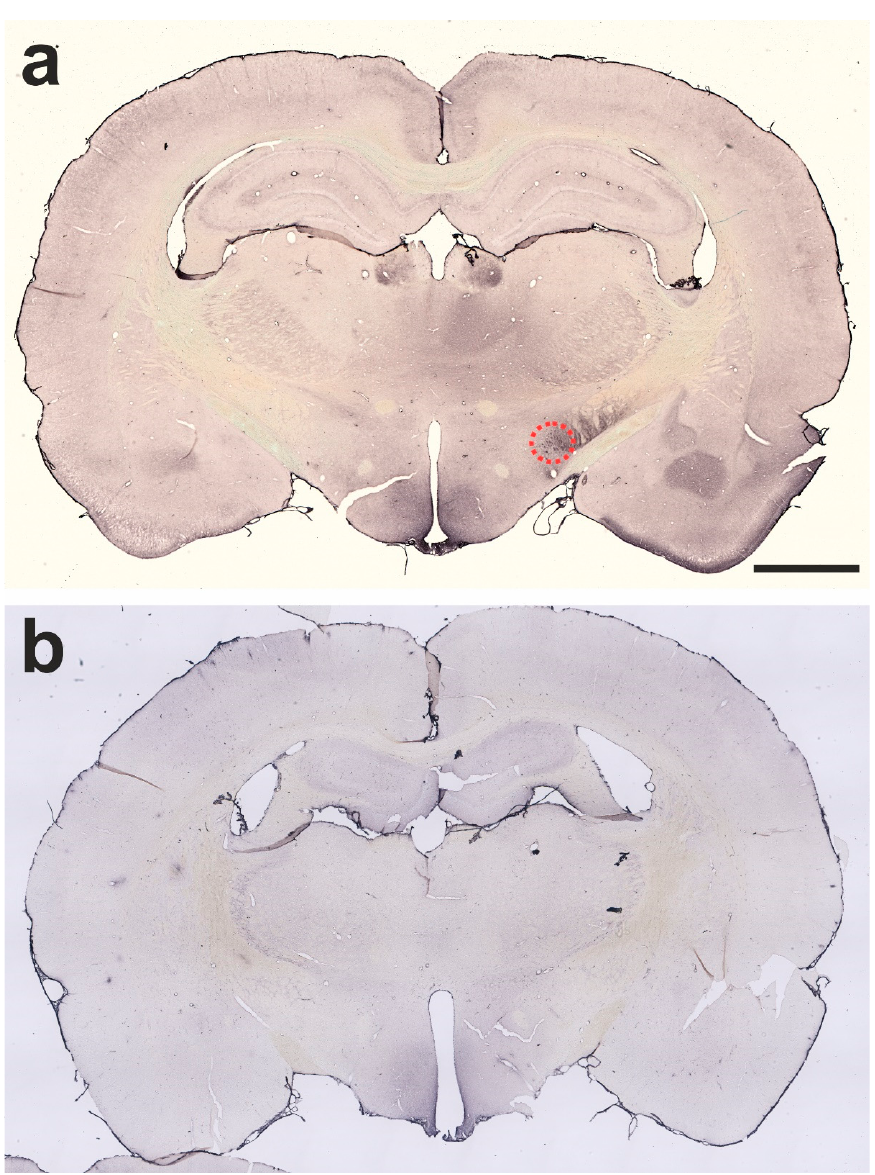
Figure 13. The 30 µm-thick frontal sections immunohistochemically stained for cleaved SNAP-25 of the diencephalon of a rat treated with 1 ng of BoNT-A on the right side one month previously ( a ) and a rat treated with vehicle solution 12 months previously ( b ). The medial right forebrain bundle is marked by a red dash line ( a ). A high immunoreactivity of the right medial forebrain bundle is clearly recognizable in ( a ). The scale bar corresponds to 2 mm for ( a , b ).